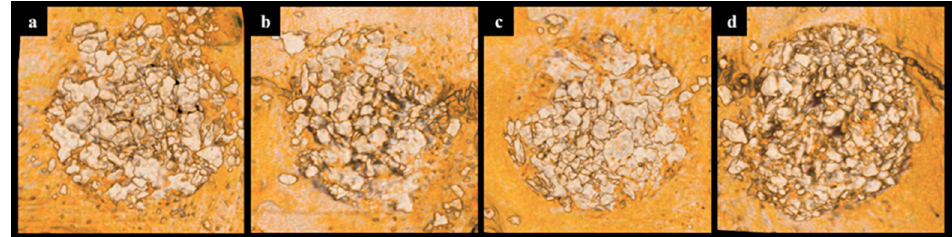
Figure 9. Micro-CT reconstructed images of each group: ( a ) BCP (control) group; ( b ) BCP/CMC group; ( c ) BCP/c-CMC group; and ( d ) BCP/HyA group. Table 2. New bone volumes within regions of interest ( n = 7; mm 3 ).